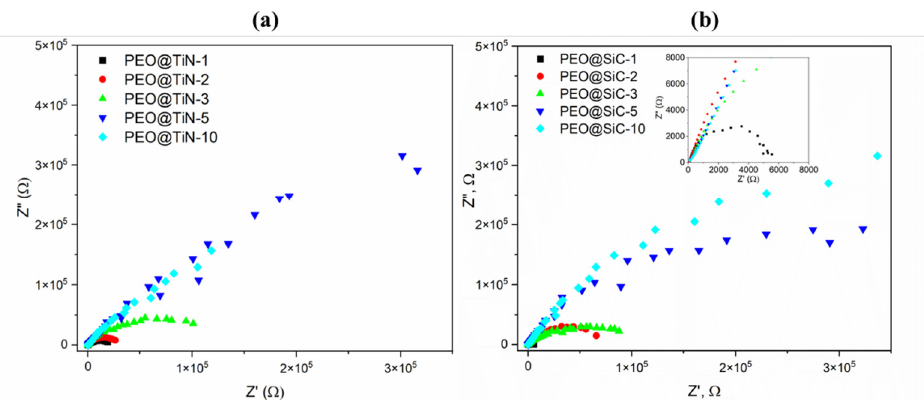
Figure 5. Nyquist plots for ( a ) PEO@TiN and ( b ) PEO@SiC coatings.